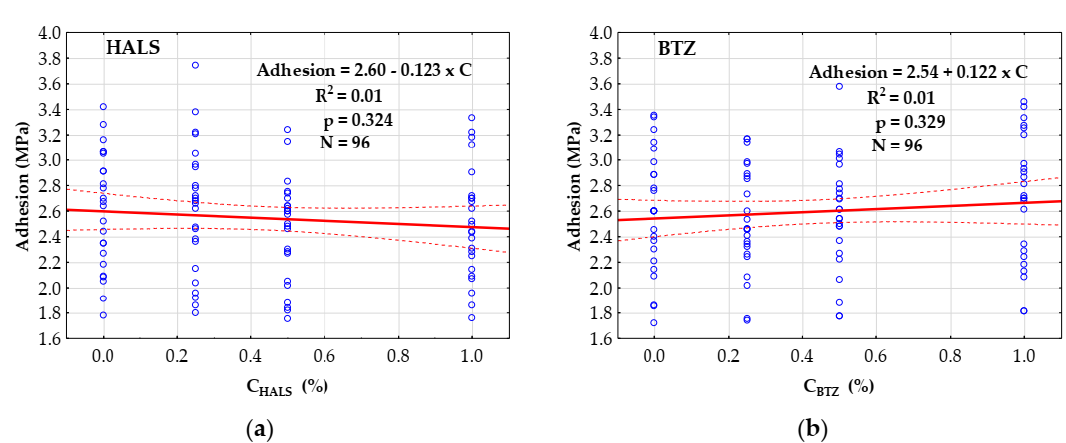
Figure 2. No e ff ect of the UV-additives ( a ) HALS and ( b ) BTZ on the adhesion strength between the coatings and the plasma modified Norway spruce wood—confirmed by the small coe ffi cient of determination R 2 equal to 0.01 and p > 0.1 for the linear correlations. Notes: the summary e ff ect of UV-additives at the defined concentrations (C = 0, 0.25, 0.5, or 1 wt.%) is from 24 data measured for 6 replicates of 2 coating types “acrylic and alkyd” and 2 weathering modes “none and 1 week in Xenotest”. The coe ffi cient of determination R2 of the linear correlation (Adhesion = a + b × C) was determined from 96 values, i.e., from 24 values for one concentration of the UV-additive multiplied by 4